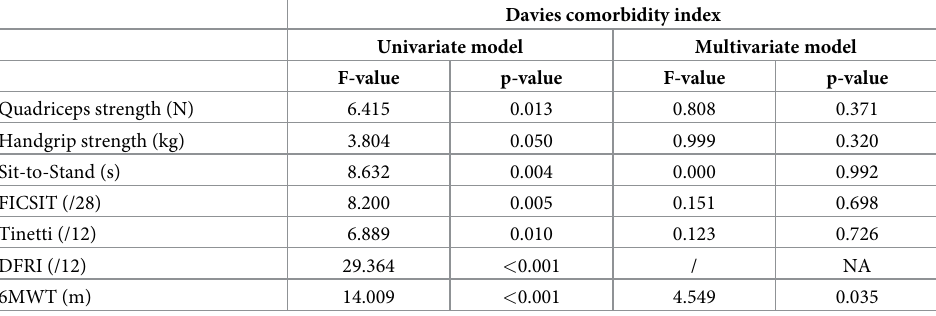
Table 6. Unadjusted least squares linear regression model of the different measures of physical performance on comorbidity (Davies comorbidity scale 0–7).